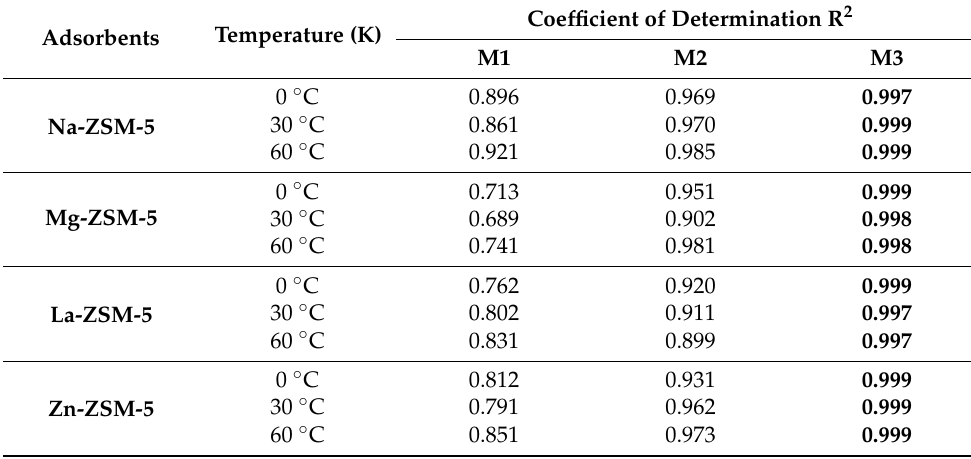
Table 1. Values of adjustment coefficient R 2 for the three